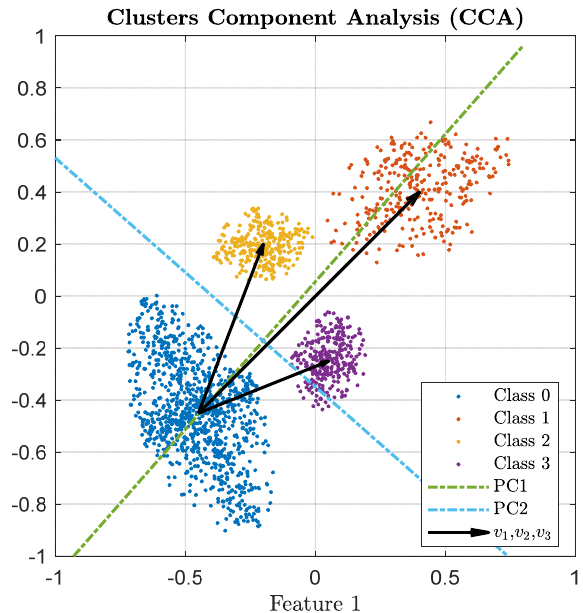
Figure 4. Qualitative representation of a multivariate clustered dataset and of the v k vectors which connect the centers of Classes k clusters with the reference Class 0. The dash-dotted lines represent the PCA results on the whole dataset.